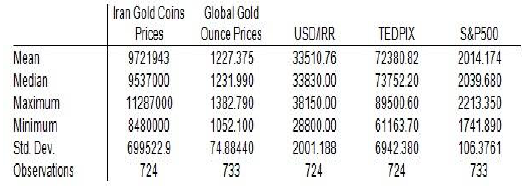
Table 1: Descriptive characteristics of the